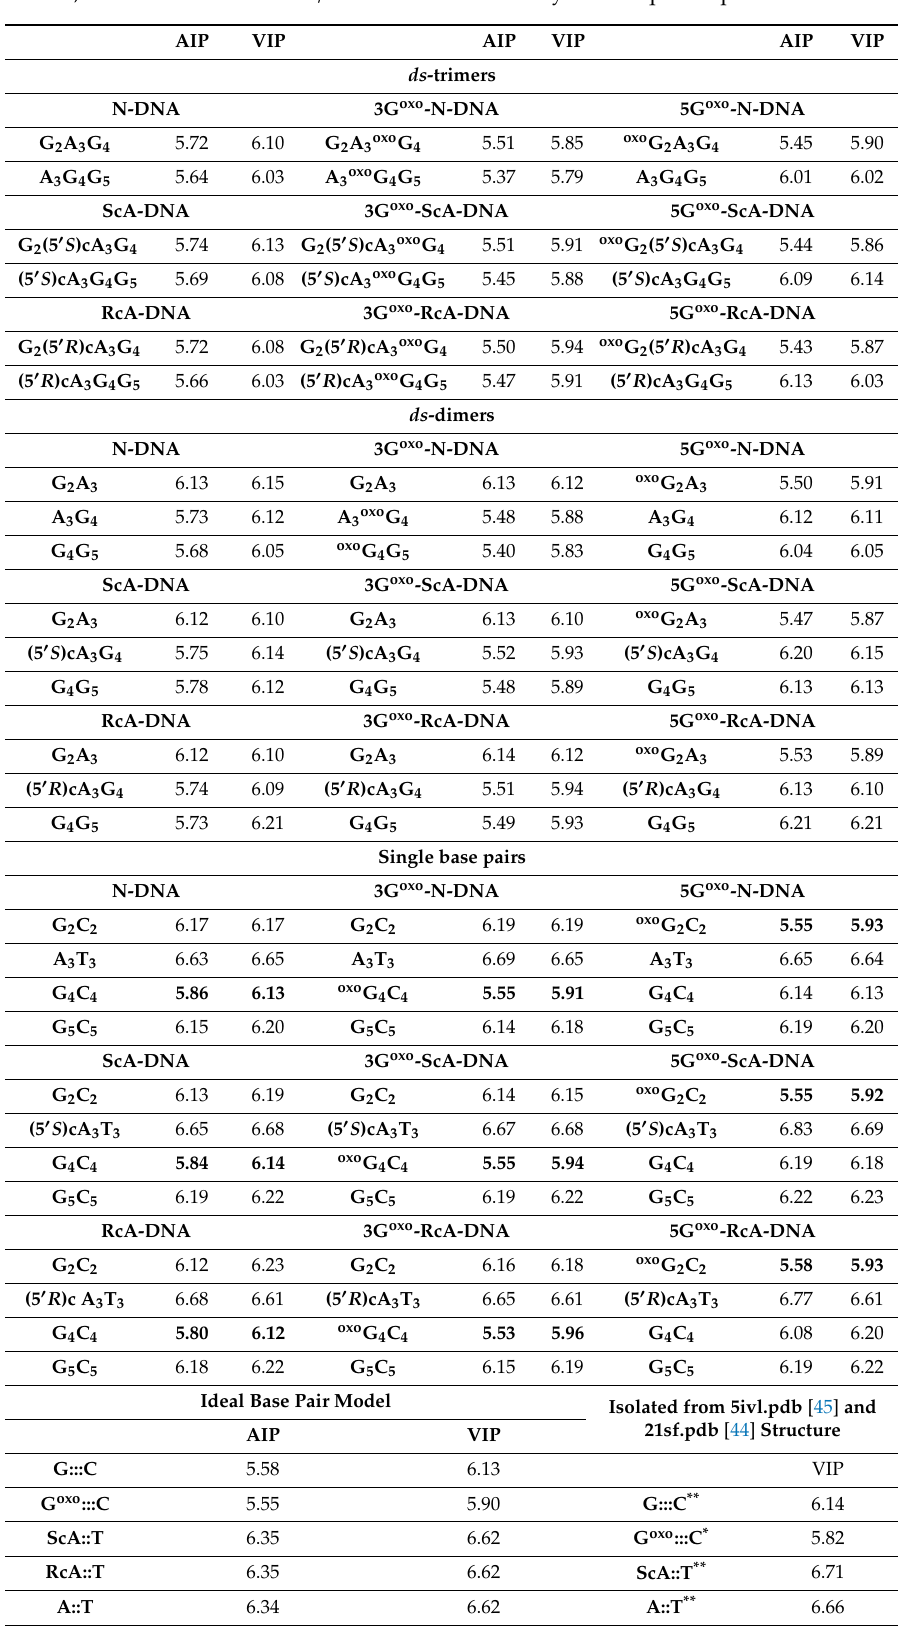
Table 6. Electronic properties in eV: Vertical (VIP) and adiabatic ionization potential (AIP) of the discussed double-stranded trimers, dimers, as well as single base pairs isolated from their parent ds -tetramers, calculated at the M062x / 6-31 + G** level of theory in the aqueous phase.